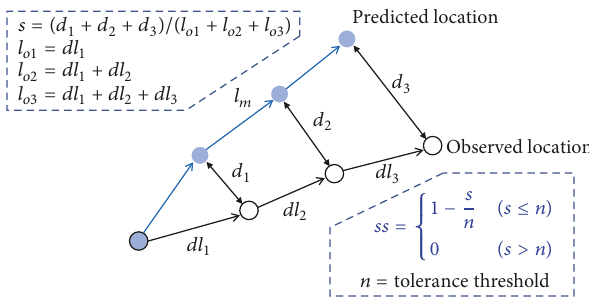
Figure 6: Formula for calculating skill score (ss) of NCLS.